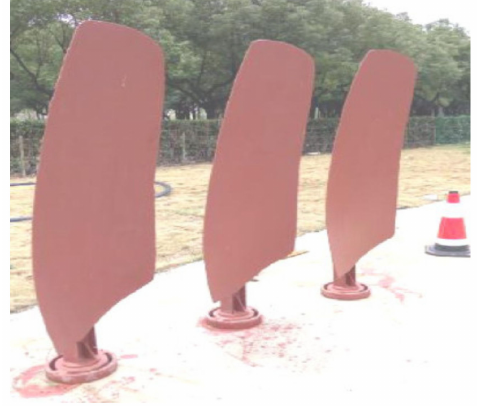
Figure 18. Thin-plate arc turbine